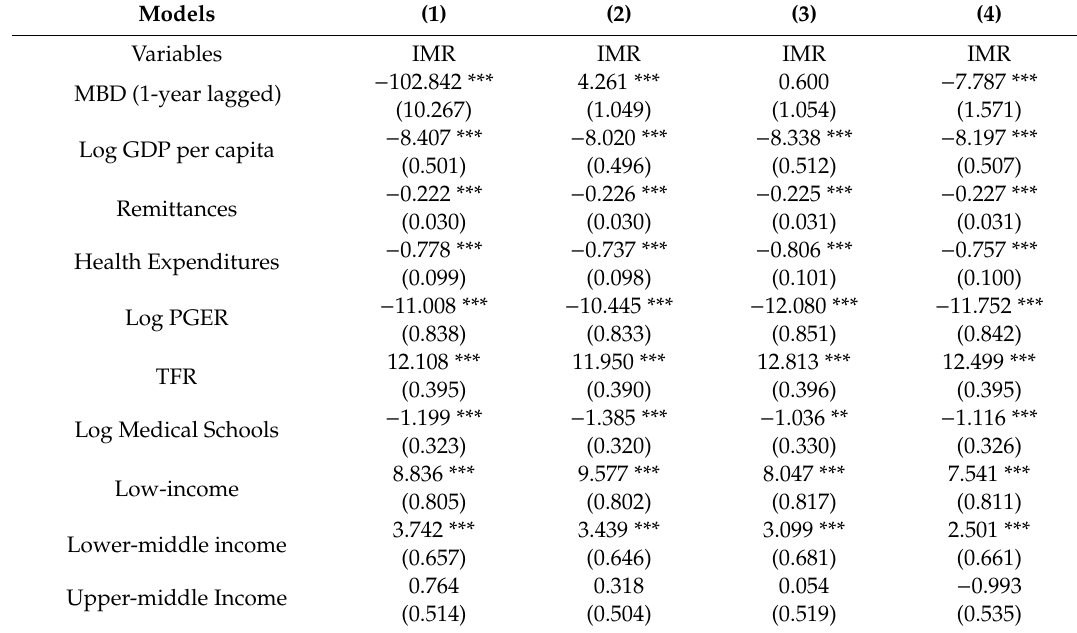
Table 6. Interaction e ff ects of MBD (1-year lagged) and levels of economy on IMR in 188 countries over